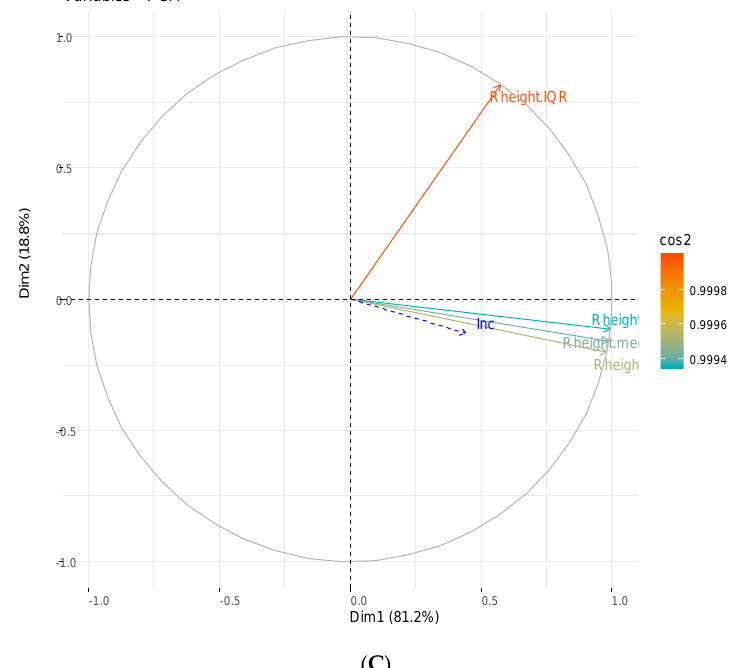
Figure 5. Principal component analysis (PCA) of meteorological and hydrological components for Koila study site. ( A ) Represent the two first components for meteorological components, ( B ) the 2nd and 3rd components and ( C ) represents the two first components for hydrological components.